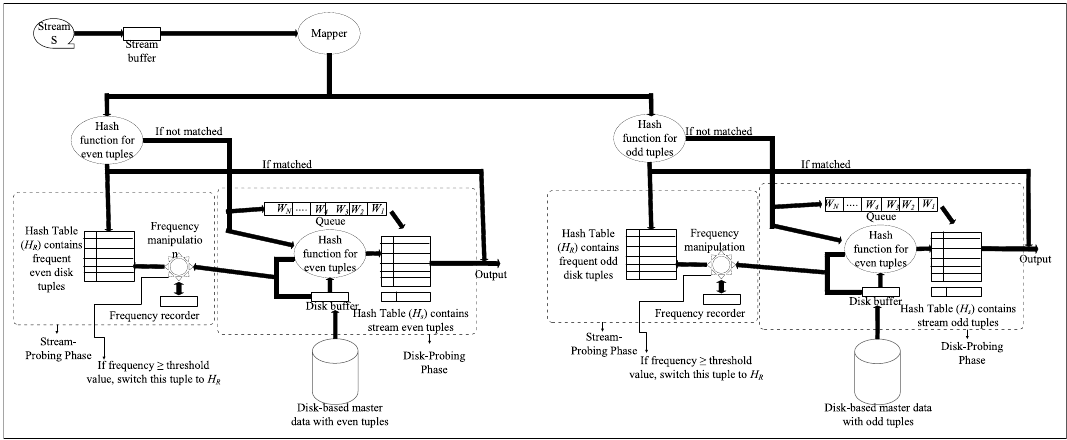
Figure 2. Execution architecture of